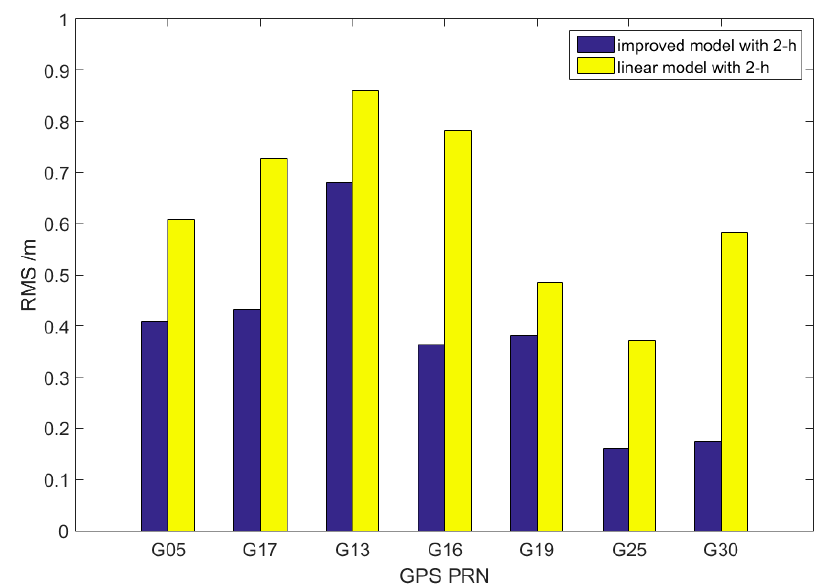
Figure 5. Comparison of 2-h results obtained with improved and linear models.